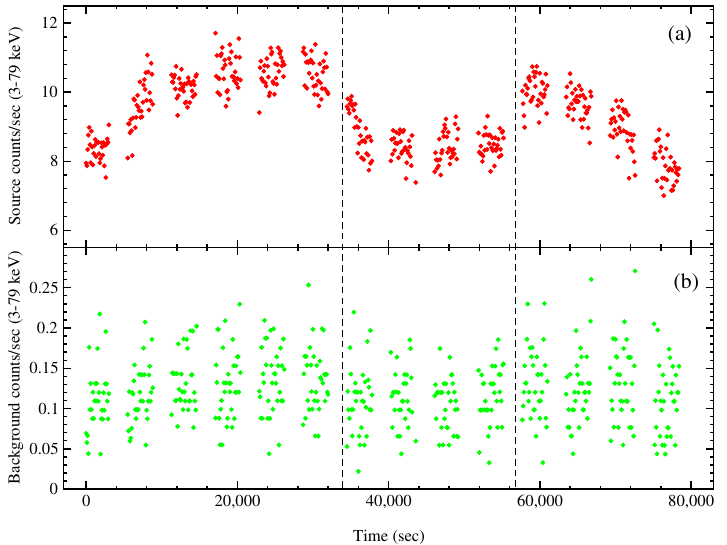
Figure 1. Variation of count rates of XTE J1908+094 from NuSTAR observation on 10 April 2019. The upper panel ( a ) shows the count rate for the source and the lower panel ( b ) shows the count rate of the background. The! background count is less than 2% of the source